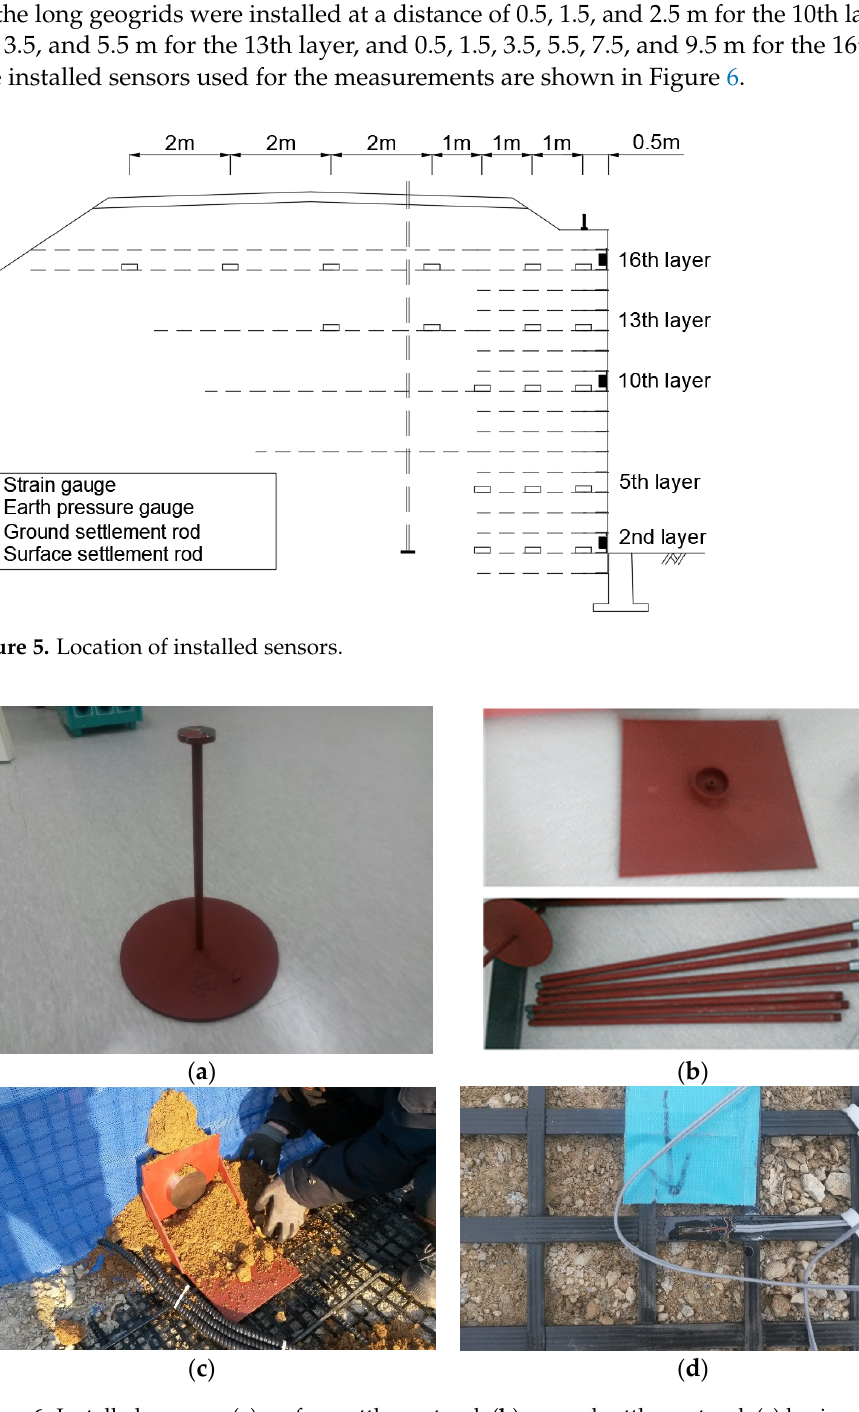
Figure 6. Installed sensors: ( a ) surface settlement rod; ( b ) ground settlement rod; ( c ) horizontal earth pressure meter; ( d ) strain gauge.